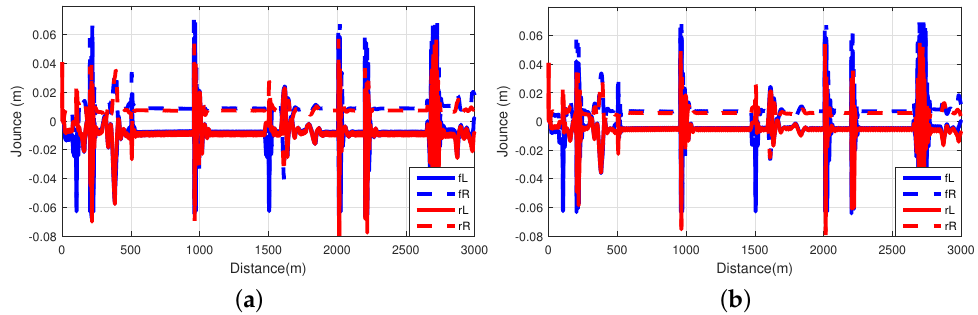
Figure 16. ( a ) Suspension deflection without adaptive control. ( b ) Suspension deflection with adaptive control.